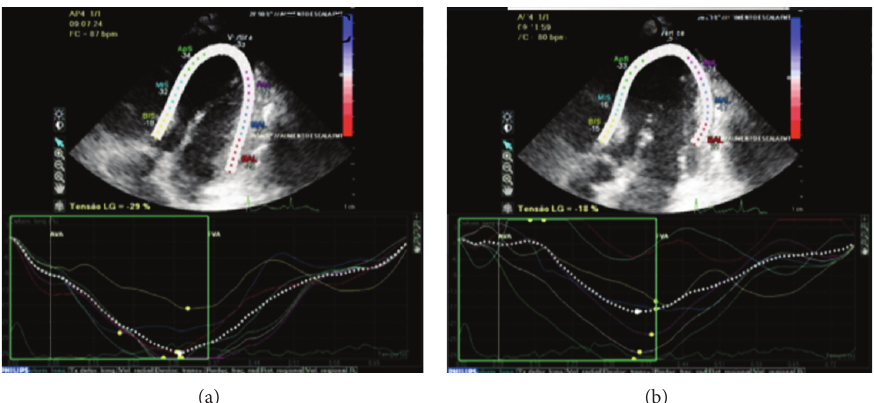
Figure 1: Speckle tracking echocardiogram with Doppler. Comparison between images during and after dobutamine infusion ((a) and (b)), showing differences in systolic global strain (29% and 18%,